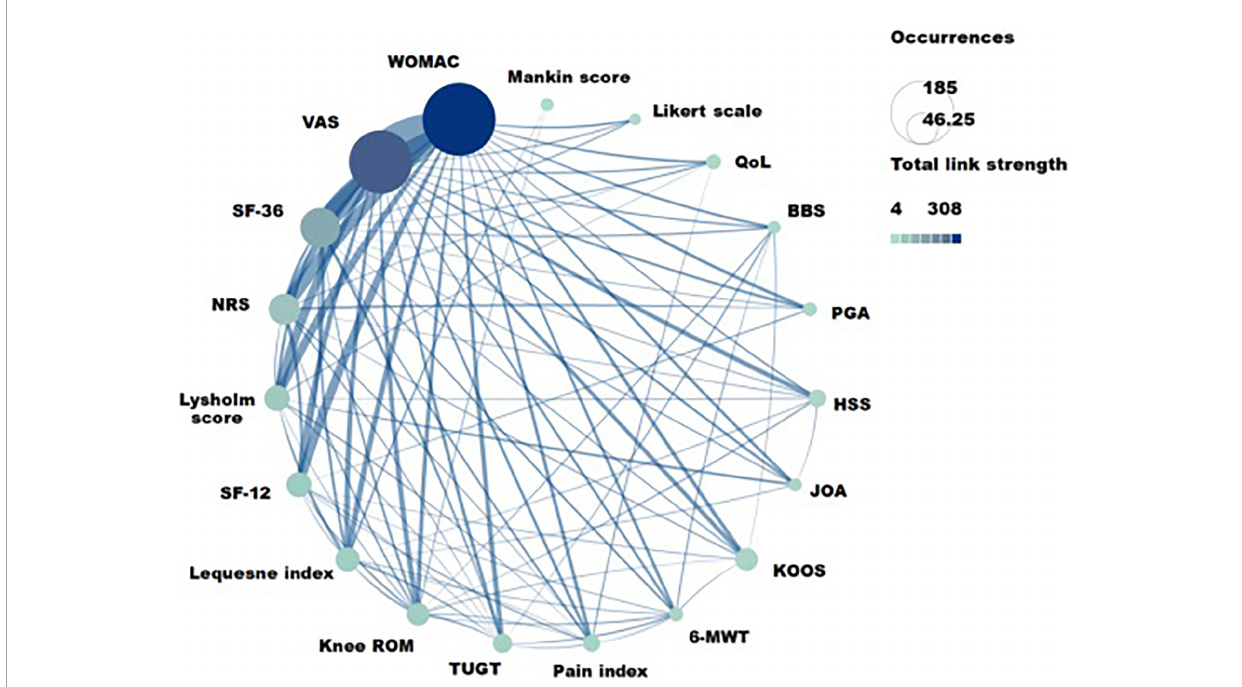
FIGURE11 The evaluation indexes with co-occurrence frequency greater than five related to traditional Chinese non-pharmacological therapies on knee osteoarthritis (KOA). WOMAC, The western Ontario and McMaster universities osteoarthritis index; VAS, Pain visual analog scale; NRS, Numeric rating scale; Kee ROM, Knee range of motion test; TUGT, Timed up and go test; 6-MWT, 6-Minute walk test; KOOS, The knee injury and osteoarthritis score; JOA, Japanese Orthopedic Association knee score; HSS, Hospital for special surgery knee score; PGA, Patient Global Assessment; BBS, Berg balance scale; QoL, Qualiy of